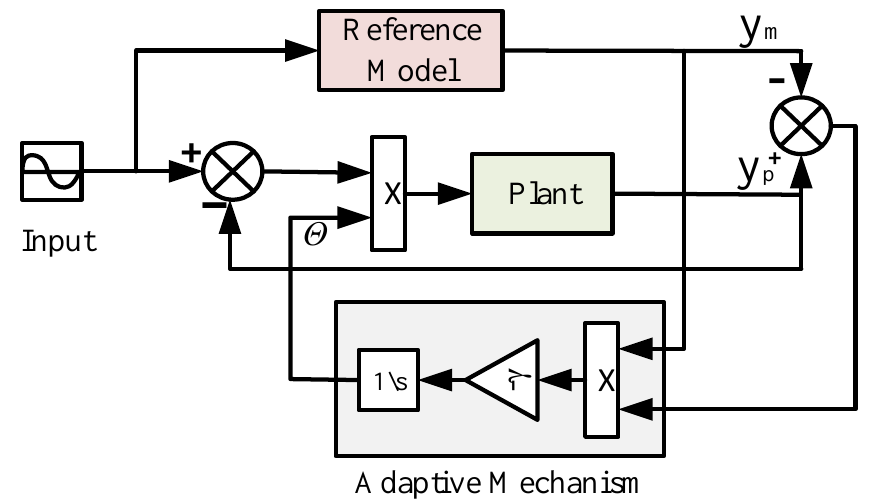
Figure 5. Schematic of the MRAC control